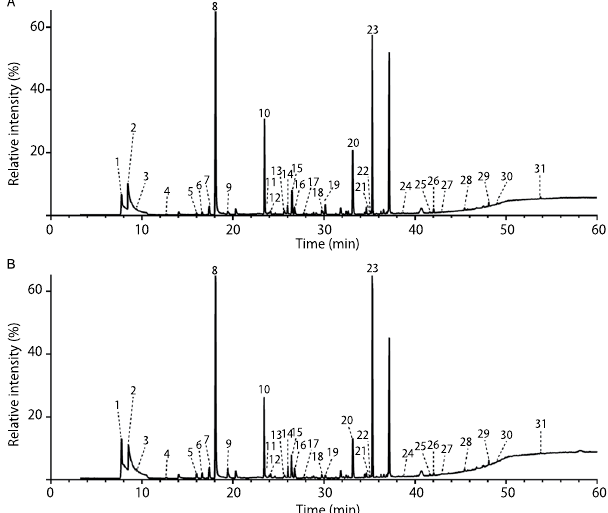
Figure 2. Typical GC-MS total ion chromatogram (TIC) of urinary volatile organic compounds (VOCs) in sham-operated and full-kindled mice. ( A ) Sham-operated mouse ( B ) Full-kindled mouse. The TICs were obtained from the analysis of the samples (200 µ L) by HS-SPME (DVB/CAR/PDMS, 50/30 µ m, 2 cm) and GC-MS equipped with an InertCap Pure-WAX column (60 m + 10 m pro-guard line and 2 m transfer line, 0.25 mm i.d., 0.5 um thick). The extraction temperature and time were respectively 45 °C and 60 min. Desorption was performed at 240 °C for 10 min. The injection was pulsed splitless (closed for 3 min). Temperature programming consisted of an initial temperature 40 °C for 10 min, followed by an increase of 5 °C/min to 240 °C, and a 10 min hold at the final temperature. Numbers indicate the following metabolites, which showed similarity indices above 85%: (1) carbon dioxide/carbamic acid, monoammonium salt/dl- alanyl-l-alanine; (2) trimethylamine; (3) methanethiol; (4) acetone; (5) 2-butanone; (6) butanal, 2-methyl-; (7) ethanol; (8) 2-hexenal, 2-ethyl-; (9) 2-pentanone; (10) 2-pentenal, 2,4,4-trimethyl-; (11) disulfide, dimethyl; (12) butanenitrile, 2-methyl-; (13) 3-penten-2-one; (14) 1-butanol; (15) RI1148; (16) methane, nitro-; (17) 2-heptanone; (18) 4-hepten-2-one, (E)-; (19) 5-oxohexanenitrile; (20) 2-acetyl-1-pyrroline; (21) dimethyl trisulfide; (22) 1-nitro-2-methyl propene; (23) 3,4-dehydro-exo-brevicomin; (24) benzaldehyde; (25) butanoic acid, 3-methyl-; (26) acetophenone; (27) 2,3,5-trithiahexane; (28) benzenamine, 3-methyl-; (29) hexanoic acid, 2-ethyl-; (30) 2-acetylpyrrole; (31) formamide,